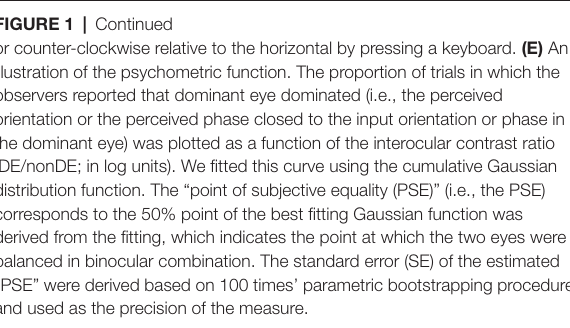
FIGURE 1 | Continued or counter-clockwise relative to the horizontal by pressing a keyboard. (E) An illustration of the psychometric function. The proportion of trials in which the observers reported that dominant eye dominated (i.e., the perceived orientation or the perceived phase closed to the input orientation or phase in the dominant eye) was plotted as a function of the interocular contrast ratio (DE/nonDE; in log units). We fitted this curve using the cumulative Gaussian distribution function. The “point of subjective equality (PSE)” (i.e., the PSE) corresponds to the 50% point of the best fitting Gaussian function was derived from the fitting, which indicates the point at which the two eyes were balanced in binocular combination. The standard error (SE) of the estimated “PSE” were derived based on 100 times’ parametric bootstrapping procedure and used as the precision of the